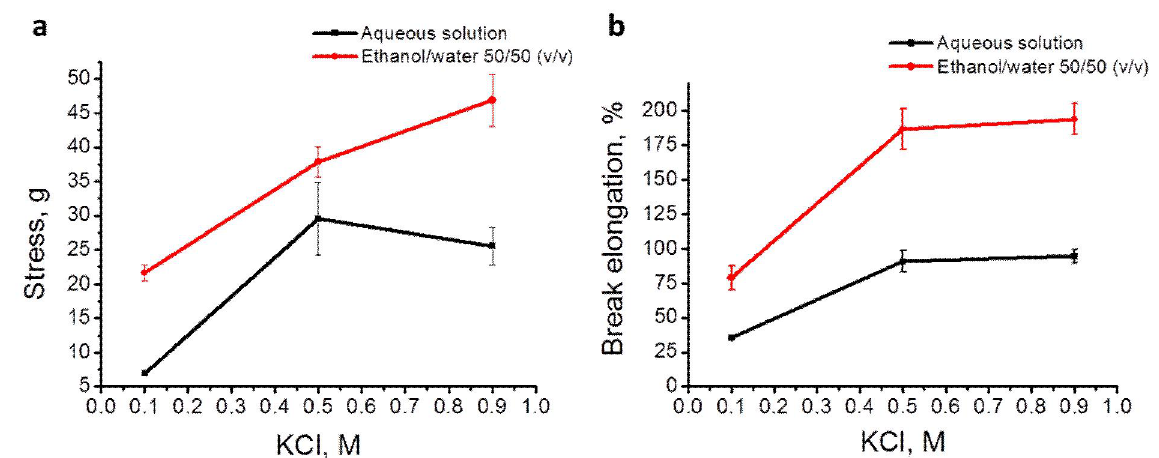
Figure 4. Effect of coagulation bath composition on as-spun fiber tensile properties, ultimate tensile stress ( a ) and elongation at break ( b ).